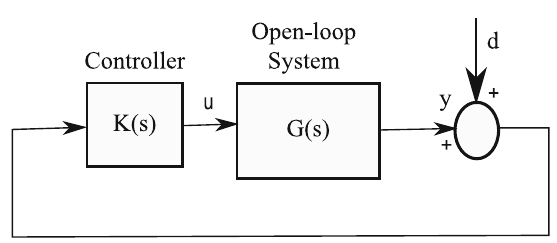
Fig. 1 Closed loop system with disturbance